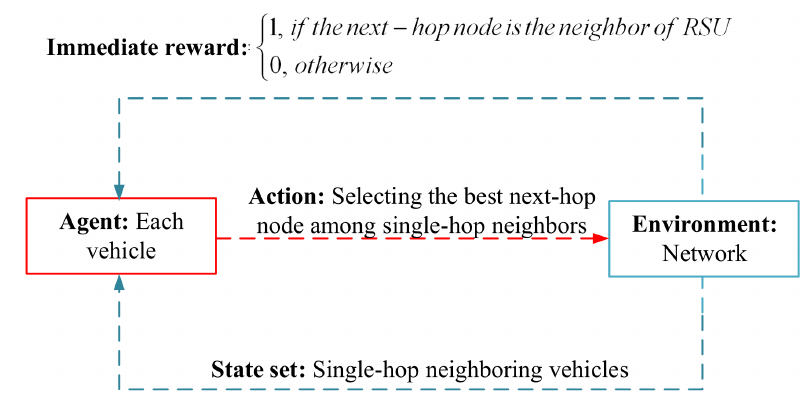
Figure 21. Learning structure in Wu et al.